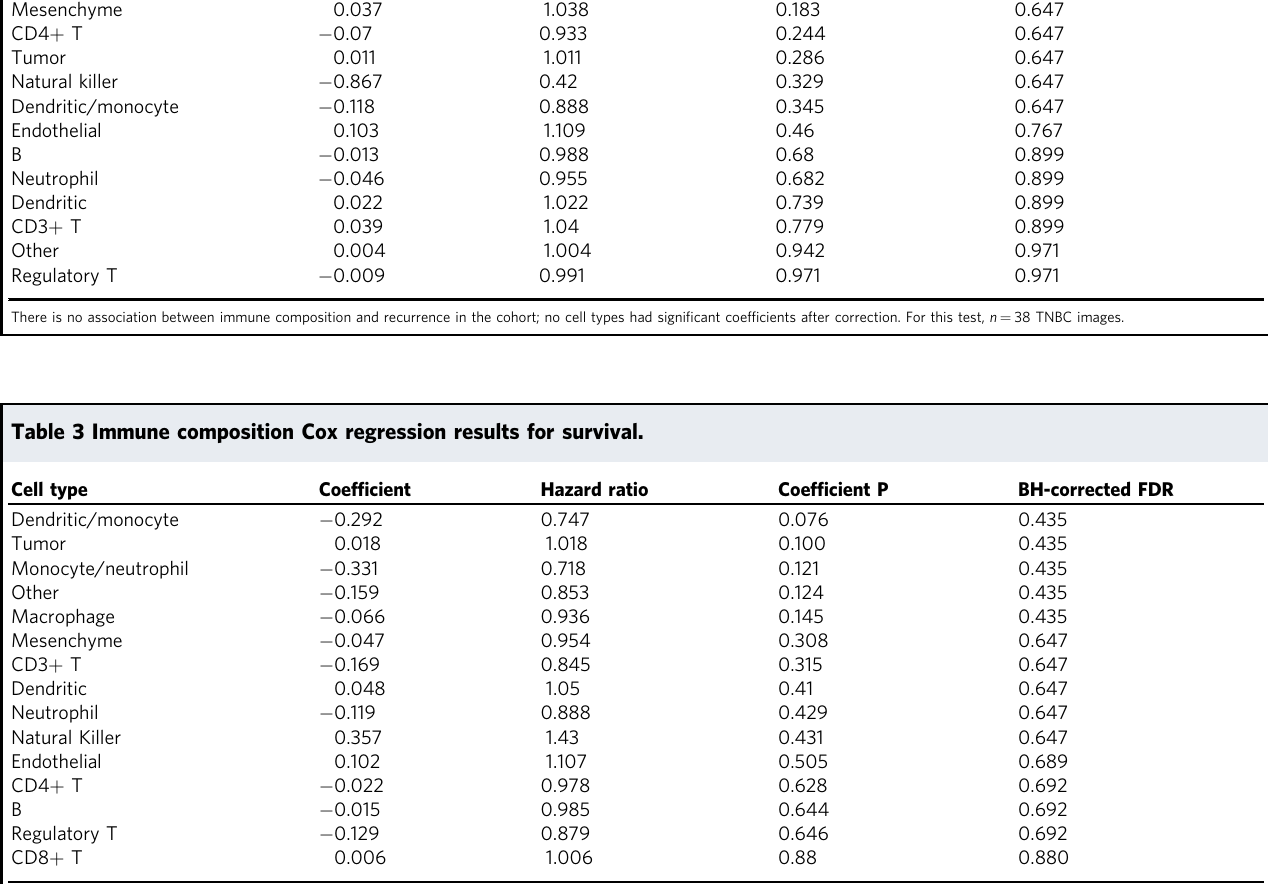
Fig. 1 Overview of the computational pipeline. a Drawing of the layered structure of MIBI scans. Each MIBI image has dimensions of 2048 × 2048 pixels with 44 channels, where each channel represents expression for each protein; i.e., each pixel in the image at each channel conveys the concentration of that protein at that location. b Color-mapped image of cell segmentation performed on a MIBI image. The cell segmentation map has one channel with dimensions of 2048 × 2048. Each cell has its own cell type represented in colors referenced in the color bar. From these cell segmentation maps and the original MIBI images, we extract cell counts, measure protein expression, and quantify co-expression. c Voronoi tessellation diagram of the cell segmentation map. Each polygon corresponds to a cell in the original segmentation, such that each point in the area of the polygon is closer to the centroid of the corresponding cell than any other cell. Each polygon borders a fi nite number of other polygons, simulating adjacencies between cells. d Using Voronoi diagrams, we analyze interactions between neighboring cells. e An interaction matrix is computed for each patient, with the entry at row A and column B representing the number of times a cell positive for protein A was adjacent to a cell positive for protein B (top). The top half triangle of the matrix, split across the diagonal, is selected, as shown with the purple rectangles. These rectangles are then fl attened to form one feature vector, i.e., interaction features, for each patient. f Interaction features are used to cluster patients, and the two patient clusters are compared with regard to recurrence/survival using Kaplan – Meier curves and the log-rank test.